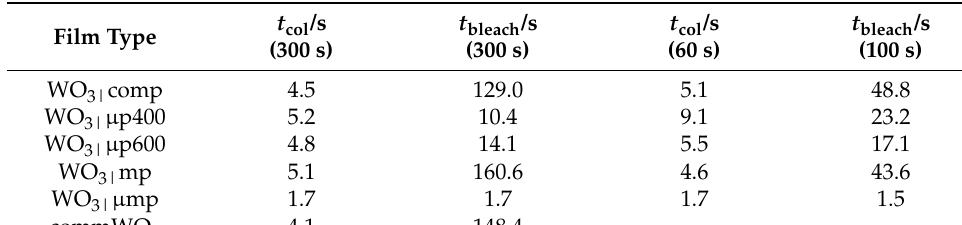
Table 9. Response times t col and t bleach of the different films obtained from CA measurements after prior opposite polarization for either 60 s, 100 s, or 300 s.